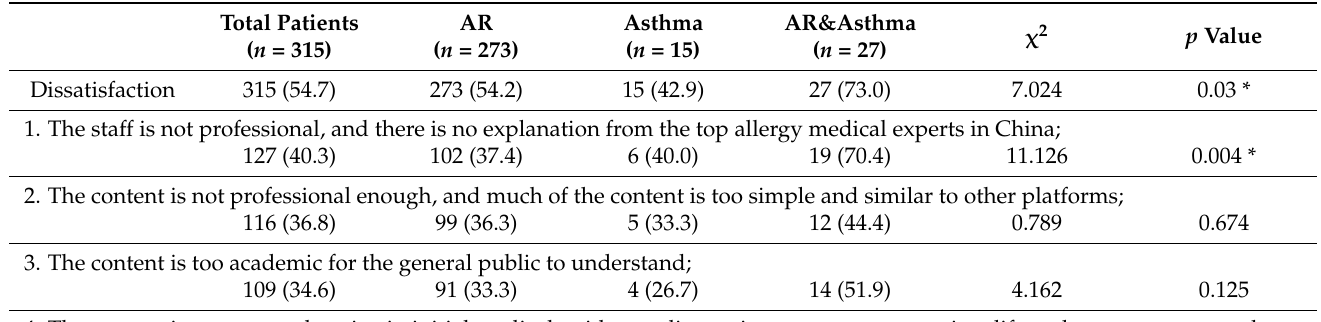
Table 5. Dissatisfaction with and necessary improvements to the online platform in the three groups ( n =